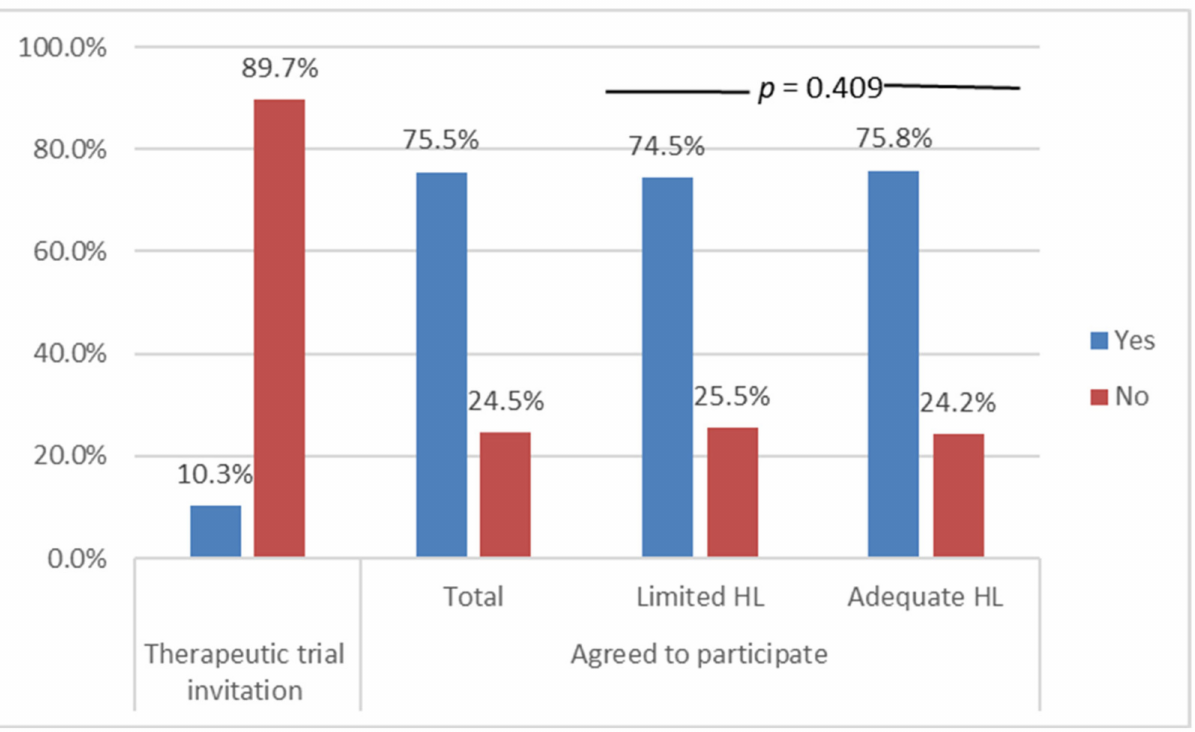
Figure 2. Clinical trial invitation rate and participation according to health literacy (HL) level. Multivariate analysis confirmed the negative effect of limited HL on the invitation to participate in a clinical trial (Table